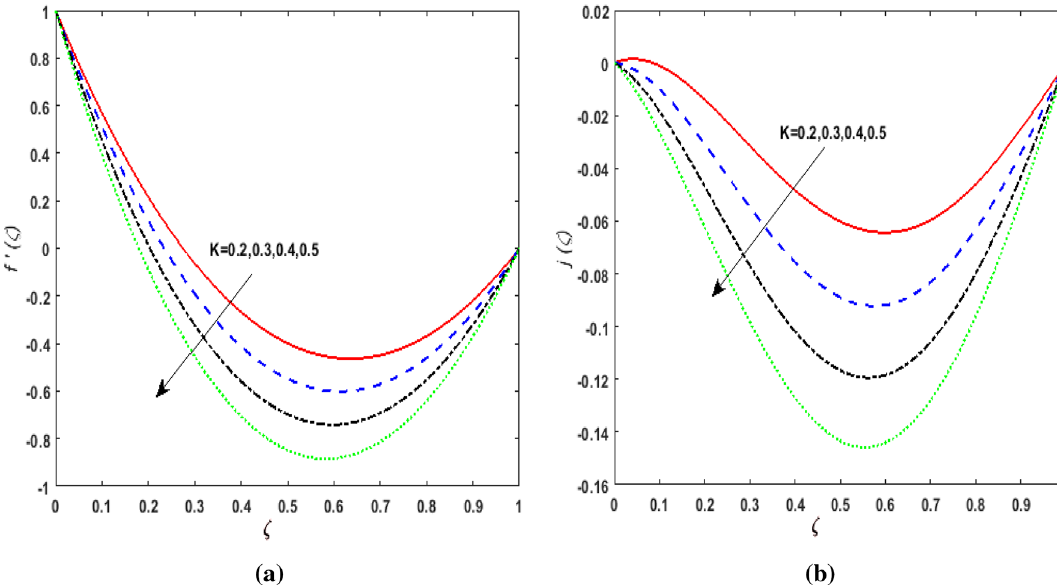
Figure 2. ( a ) Effect of suction parameter K on velocity f ′ (ζ) . ( b ) Effect of suction parameter K on velocity j (ζ)